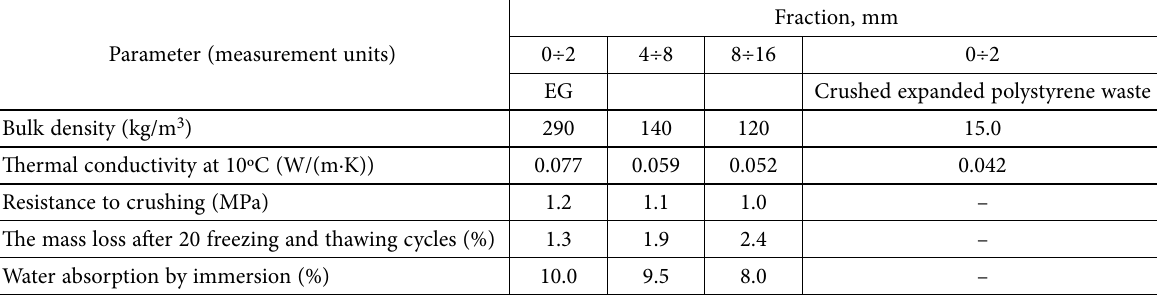
Table 1. Physical and mechanical properties of different aggregates